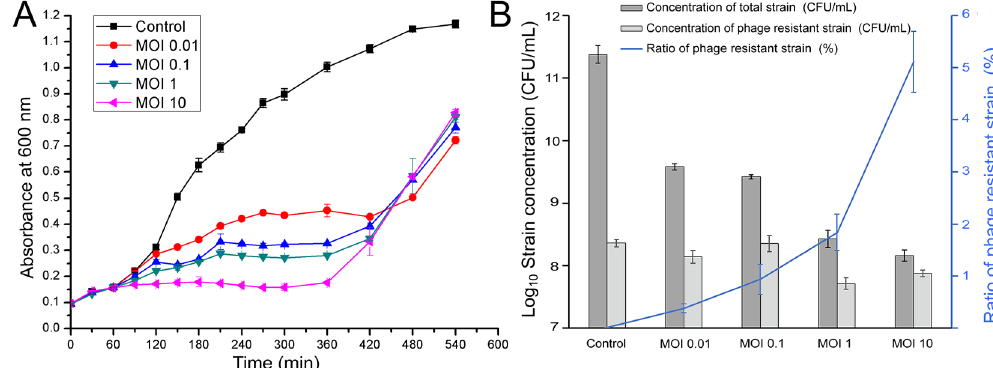
Figure 2. Control effect of phage vB_EcoS_HSE2 to the pathogenic E . coli strain 40371. ( A ) Growth curve of strain 40371 co-cultivated with phage vB_Ecos_HSE2. The strains were treated with the phage of different MOI and strain without treating by phage was used as control. ( B ) Counts of the total strains and phage resistant strains. The total strain concentrations and concentrations of phage resistant strains were tested after treating the strain with different concentrations of phage for 6 hours. The ratios of phage resistant strain were analyzed by calculating the ratio of phage resistant strains to the total